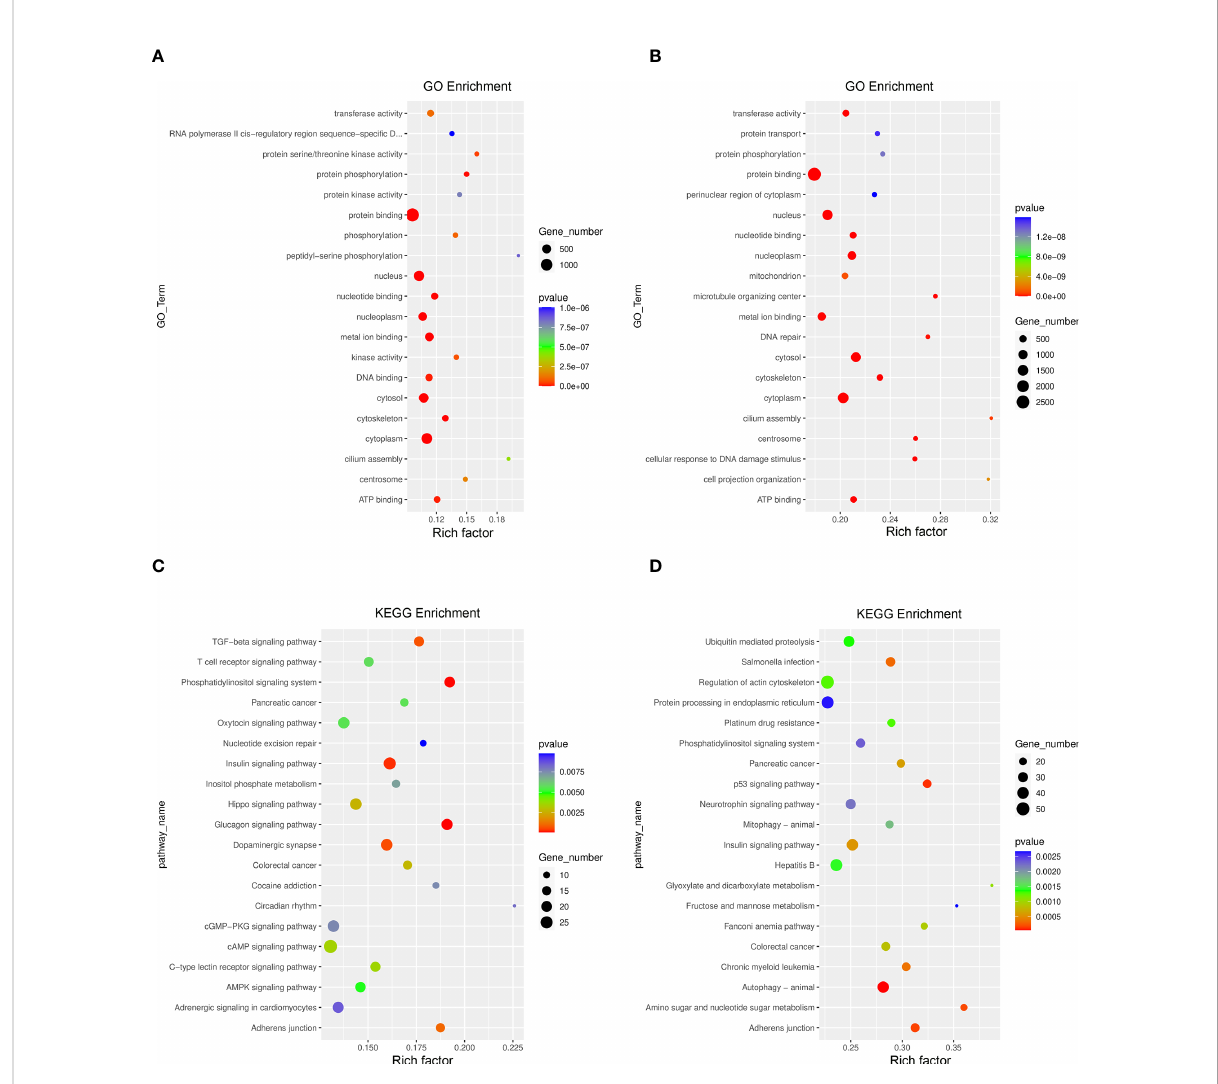
FIGURE 3 GO function and KEGG pathway enrichment of differentially methylated mRNA. (A, B) Compared with HOEC cells, top 20 signi fi cantly enriched GO terms in DOK and SCC-9 cells, respectively. (C, D) Compared with HOEC cells, top 20 signi fi cantly enriched KEGG pathways in DOK and SCC-9 cells,